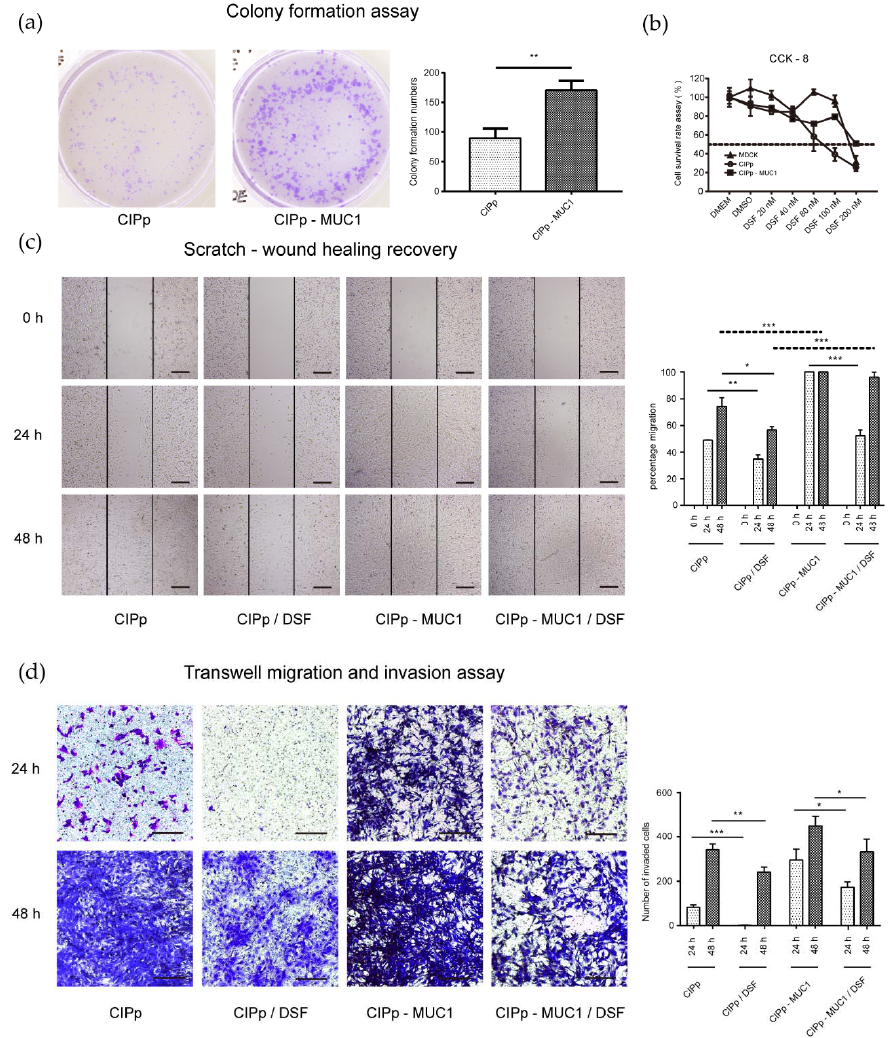
Figure 1. Overexpression of mucin 1 (MUC1) enhanced the proliferation and migration of canine mammary tumor cells. ( a ) 500/well CIPp or CIPp ‐ MUC1 cells were cultured for 10 days, and colony formation was detected by crystal violet staining and counting. ( b ) CIPp, CIPp ‐ MUC1, and MDCK cells were cultured with different concentrations of disulfiram for 48 h; cell survival rates were detected by CCK ‐ 8 staining. ( c ) CIPp and CIPp ‐ MUC1 cells growing confluently in 6 ‐ well plates were scratched and cultured with or without 100 nM disulfiram for 24 h or 48 h. Wound healing rates were measured by dividing the newly covered area at 24 h or 48 h to the blank area at 0 h. ( d ) CIPp or CIPp ‐ MUC1 cells were seeded on the upper chamber with serum ‐ free medium with or without 100 nM disulfiram, and the lower chamber was filled with a complete medium. After 24 h or 48 h, the number of cells migrating through Matrigel was counted by crystal violet staining. Data were representative of three independent experiments. * p < 0.05, ** p < 0.01, *** p < 0.001. Bar = 100 μ m.